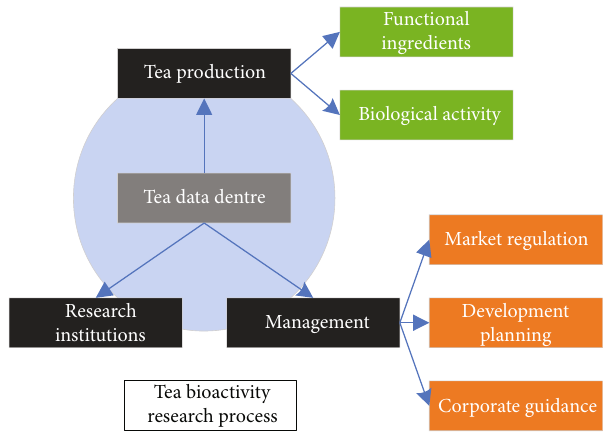
Figure 1: Schematic diagram of the study of functional components and biological activity of tea